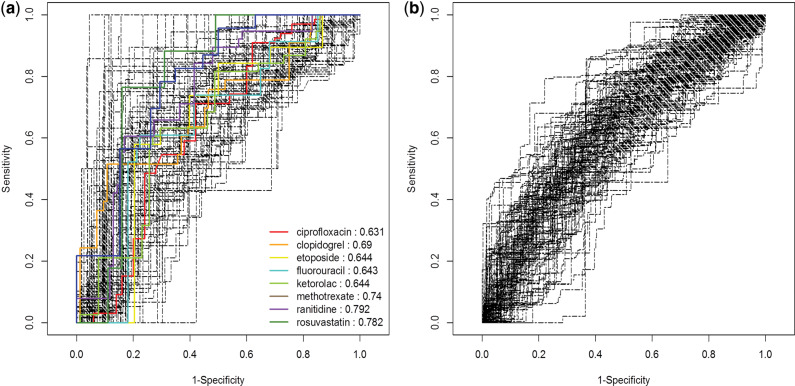
Evaluation of the ROC curves of pharmacovigilance algorithms created by (A) MetaLAB (MLLRS, AUCs = 0.69 ± 0.11) and (B) MetaNurse (MNNRS, AUCs = 0.62 ± 0.07) against the extensive RS-ADR gold standard comprising 117 and 757 MedDRA PTs, respectively, for 101 precautionary drugs. ROC curves for the 10 drugs reported by Yoon et al.13 for MetaLAB analysis against 11 817 drug-ADR pairs are presented as colored curves.